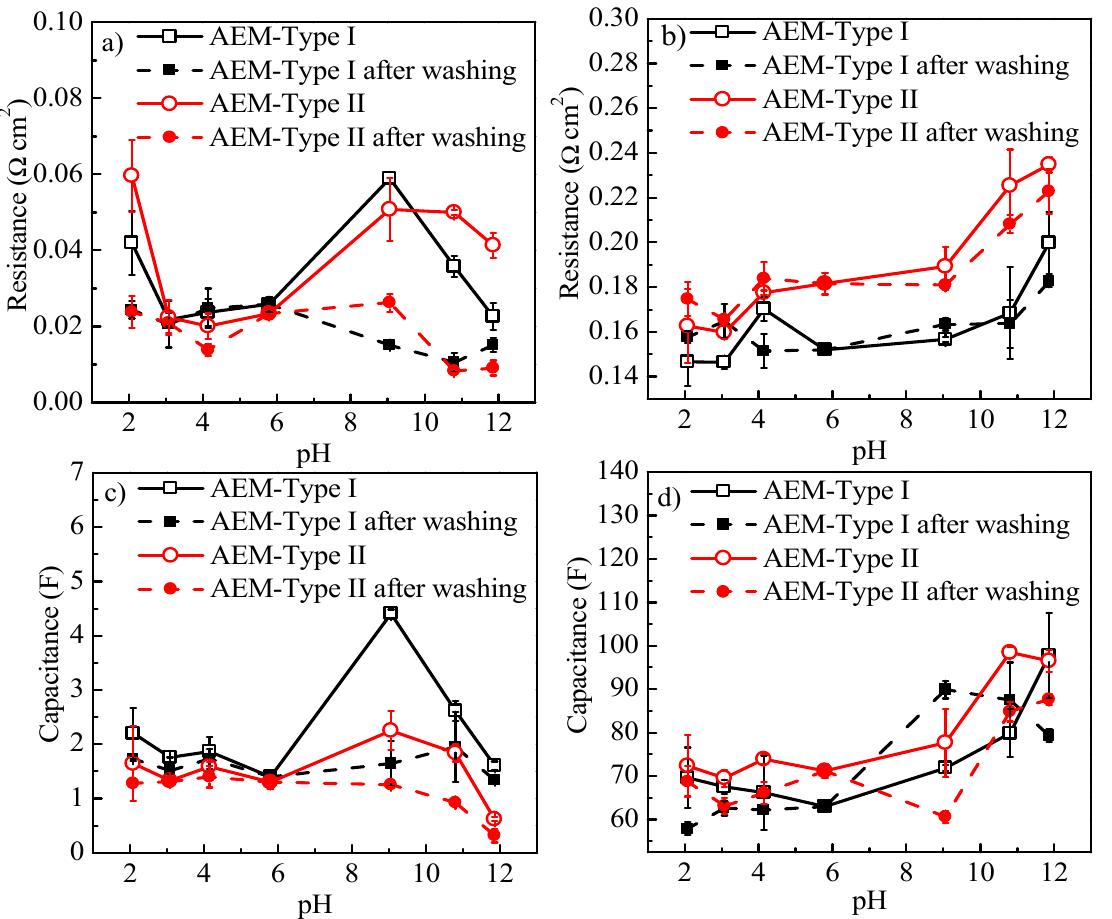
Figure 11. ( a ) Resistance of EDL ( R edl ), ( b ) resistance of DBL ( R d ), ( c ) effective capacitance of EDL ( C edl ), and ( d ) effective capacitance of DBL ( C d ) in for anion exchange membranes before and after washing with 0.5 mol/L NaCl solution.